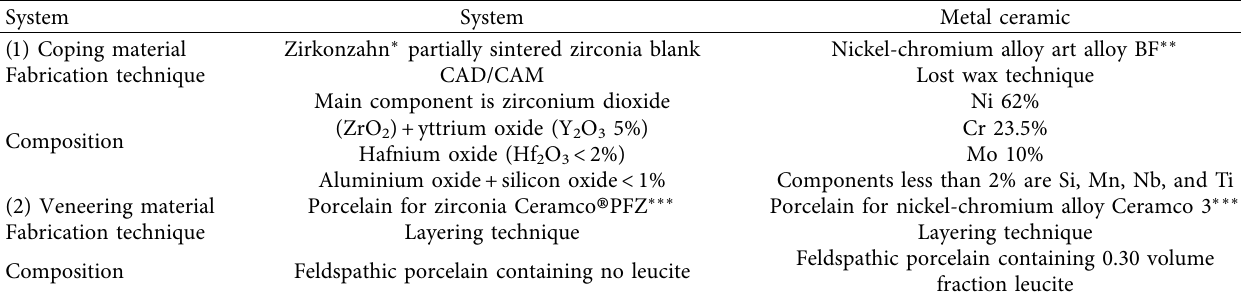
Table 1: Crown materials used in this study.